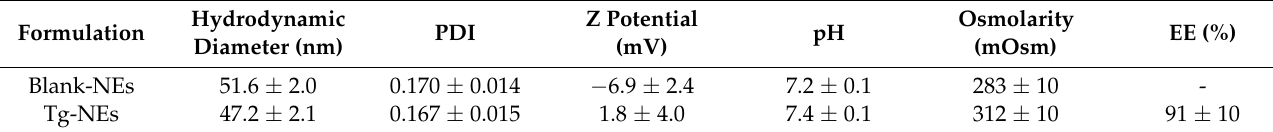
Table 4. Physicochemical characteristics of nanoemulsions ( n ≥ 18).